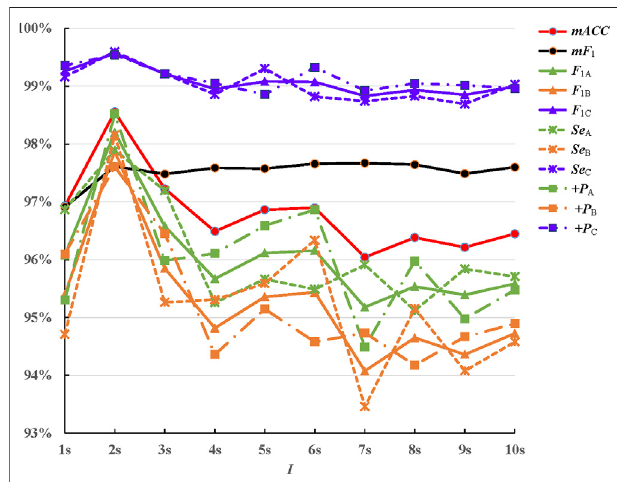
FIGURE 6 | Classi fi cation results for invariance scale I (cid:1) 1 s , 2 s , / 8 s , 9 s , 10 s .